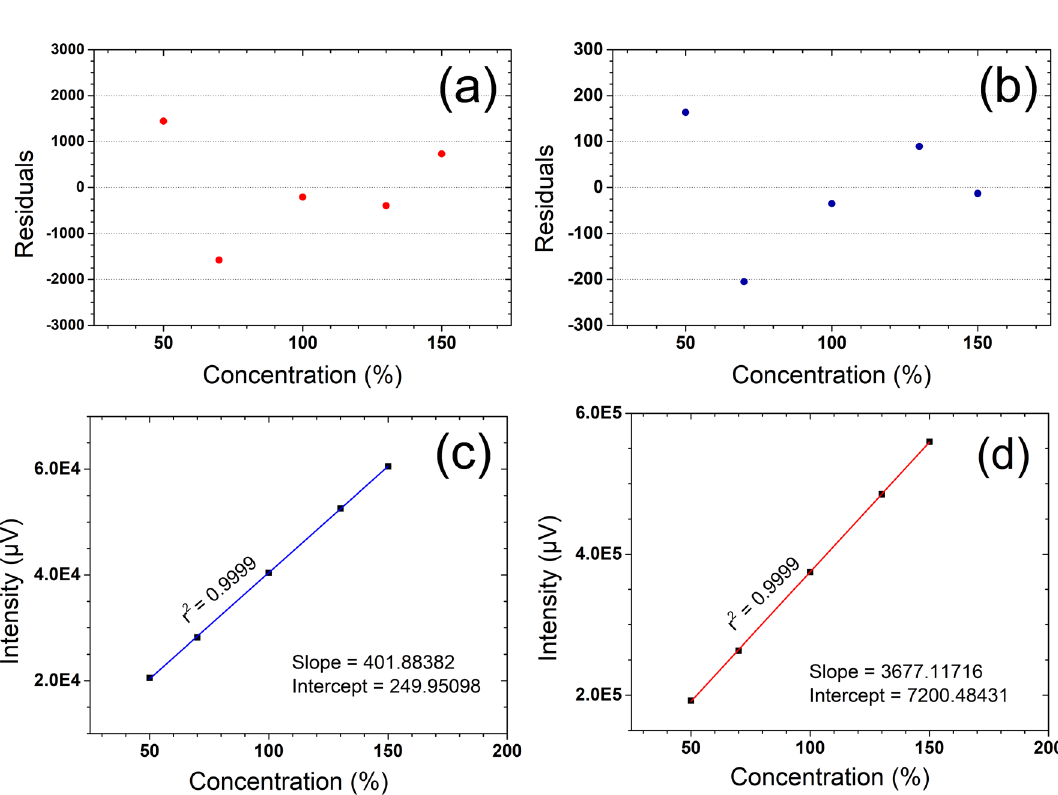
Figure 3. Linearity and residual plot diagrams for CBD and THC assay method validation ( a ) Residual plot for CBD ( b ) Residual plot for THC ( c ) Assay linearity plot for THC and ( d ) Assay linearity plot for